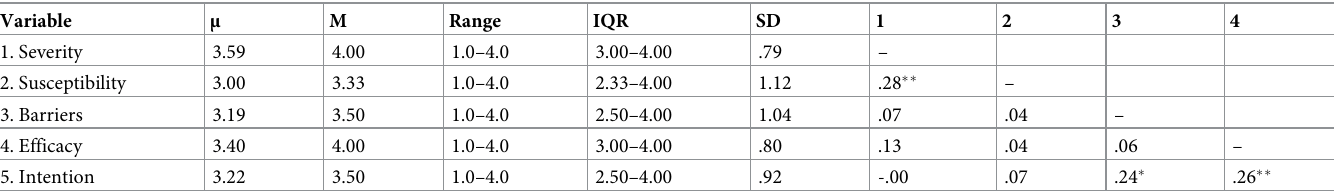
Note: μ , M, SD, and IQR are used to represent mean, median, standard deviation, and inter-quartile range, respectively. � indicates p < .05. �� indicates p <